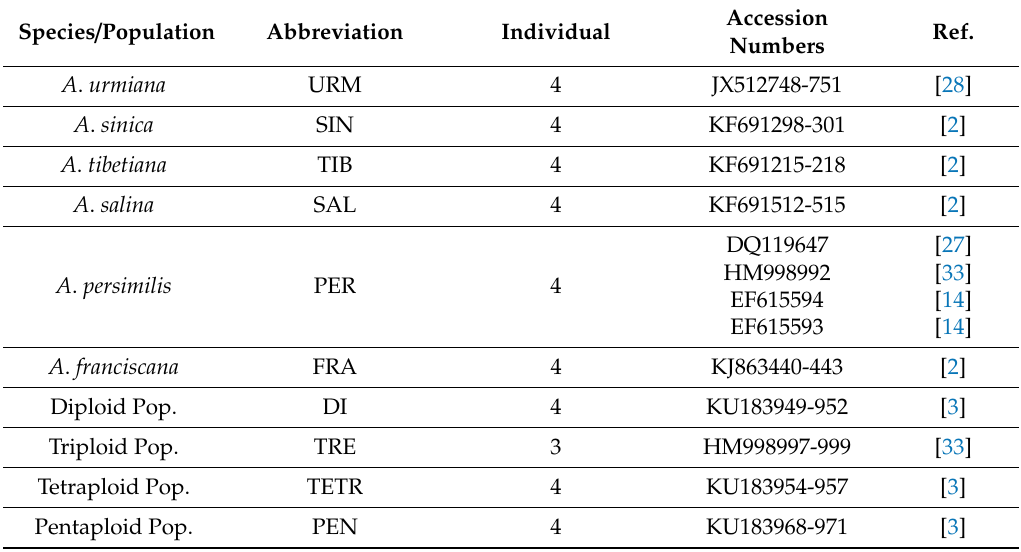
Table 2. Species information and GenBank accession numbers for COI reference sequences.